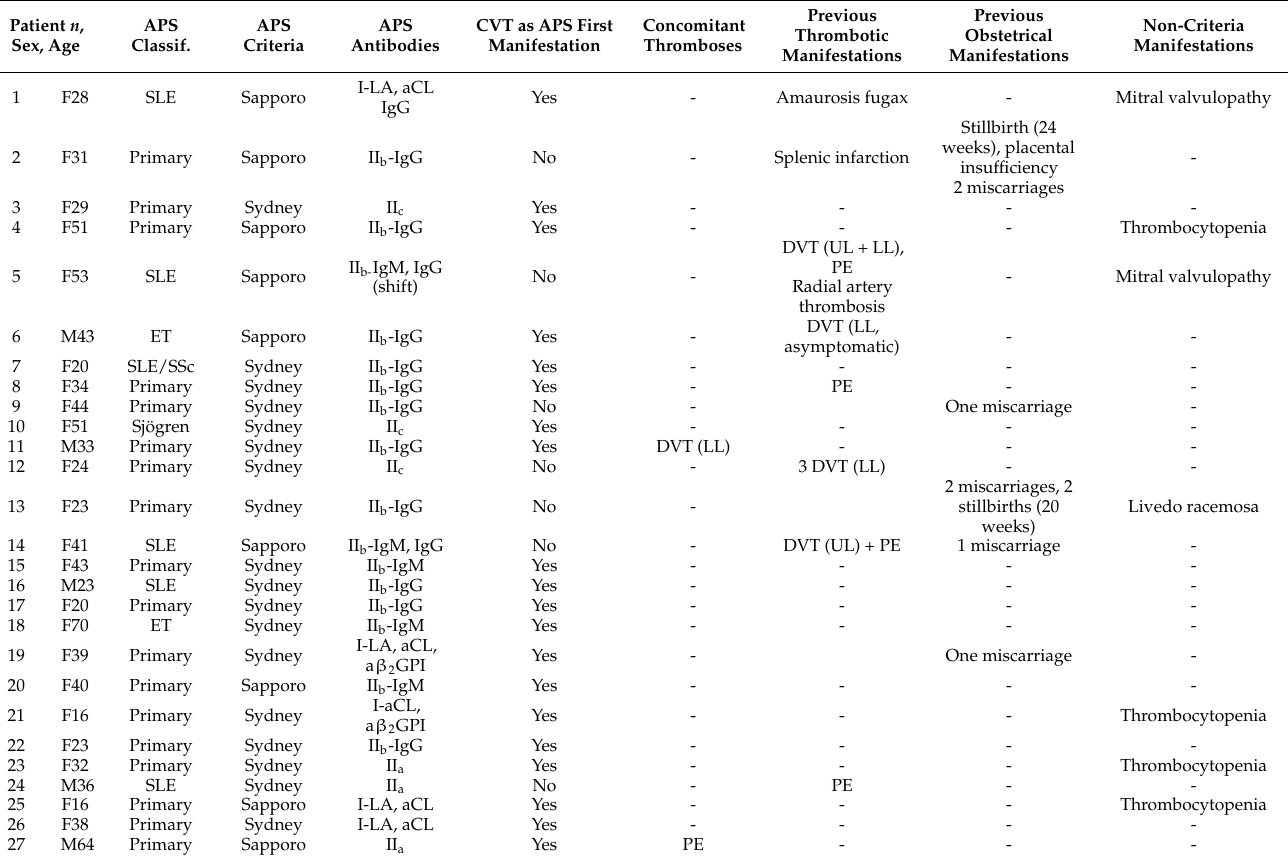
Table 3. APS characteristics. This table gathers the main information about the APS characteristics. It is noted whether it was primary APS or associated with another disease, as well as the criteria set used at diagnosis. Based on the antibodies, patients were classified into the following categories: I, more than one laboratory criteria present (any combination); II a , LA present alone; II b , aCL present alone; II c , anti- β 2 -glycoprotein-I present alone. Abbreviations: F, female; M, male; SLE, systemic lupus erythematosus; ET, essential thrombocytosis; SSc, systemic sclerosis; DVT, deep vein thrombosis; UL, upper limbs; LL, lower limbs; PE, pulmonary